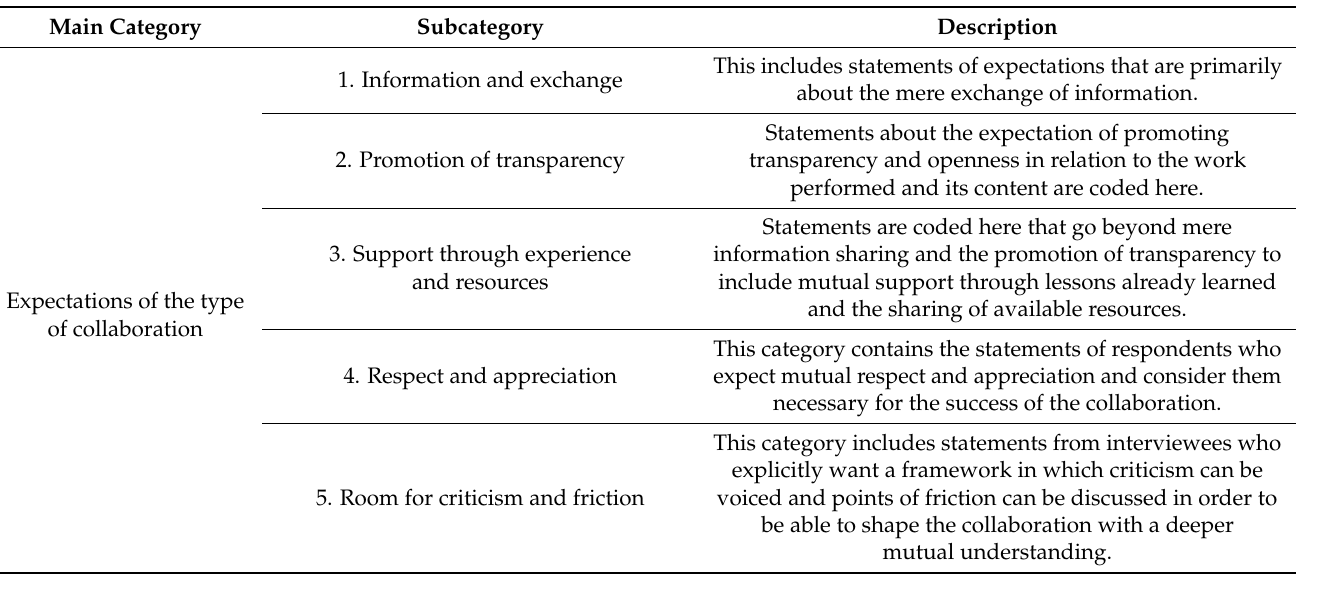
Table 1. Summary of the five dimensions of the